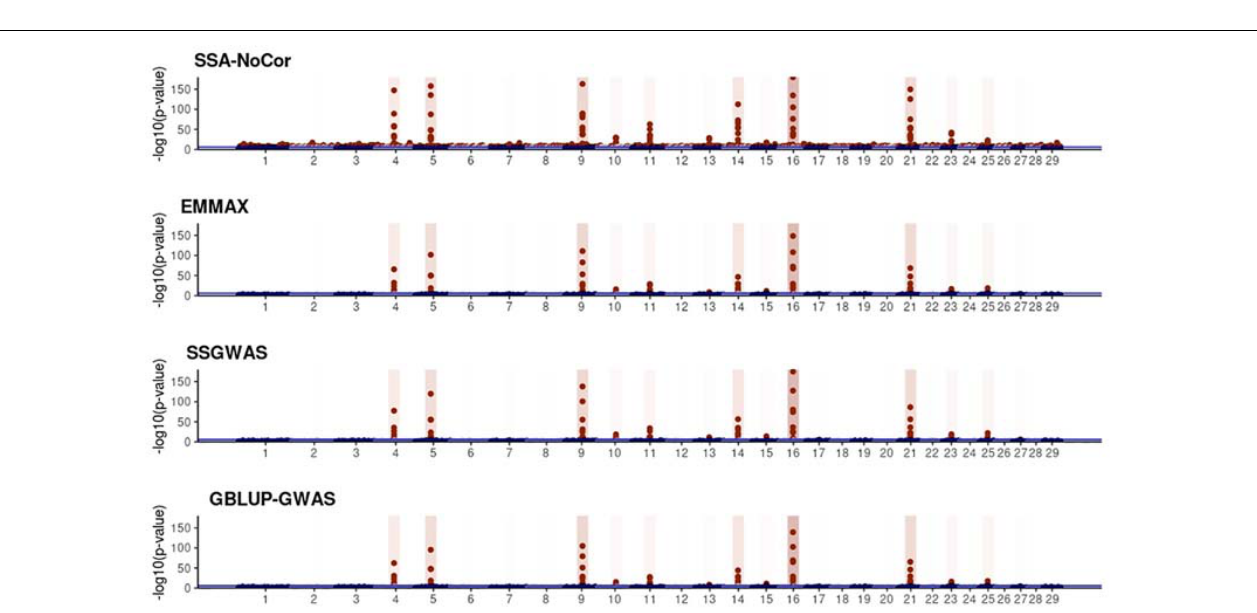
FIGURE 10 | Manhattan plots for the large population of dairy cattle when sires had an average of ten daughters. The association methods used were single-SNP analysis without correction for population structure (SSA-NoCor), efficient mixed-model association expedited (EMMAX), single-step GWAS (ssGWAS), and genomic best linear unbiased prediction GWAS (GBLUP-GWAS). Significant SNPs are indicated in red, whereas vertical bars indicate the position of the simulated quantitative trait nucleotide (QTN). The darker the vertical bar, the stronger QTN effect. The blue horizontal line corresponds to the rejection threshold based on a significance level of 0.05 with a Bonferroni correction for multiple